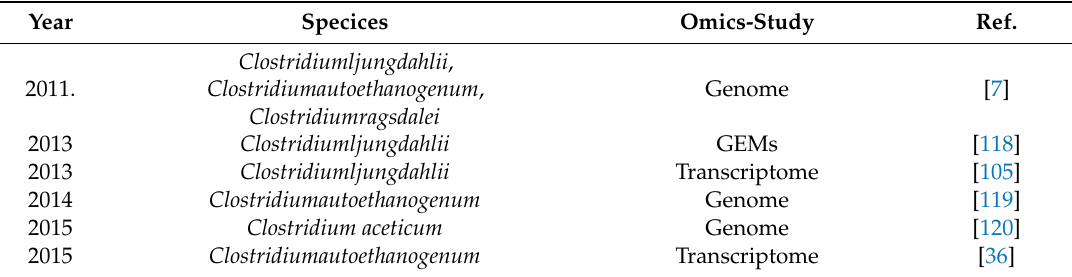
Table 4. System-level analysis of